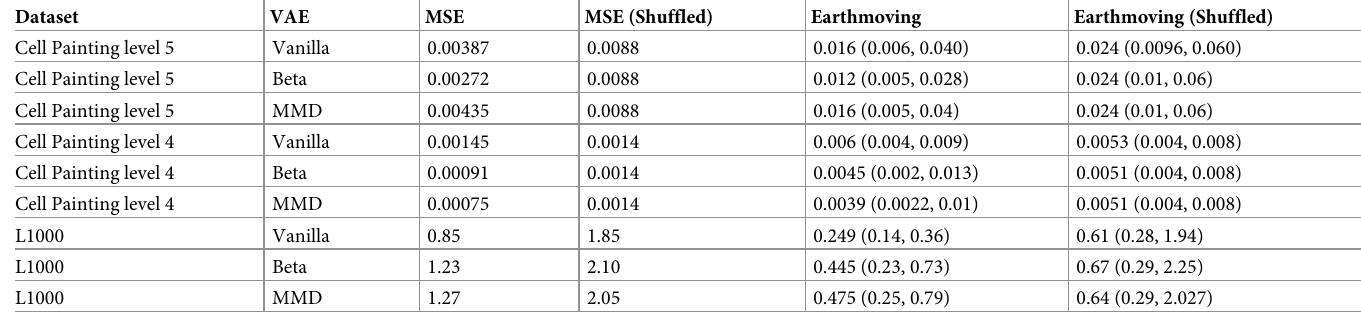
Table 1. Mean squared error (MSE) and earthmoving distance for VAE’s ability to reconstruct Cell Painting and L1000 profiles. We compare these values with results derived from shuffled models. Earthmoving distance is calculated by taking the mean of the earthmoving distance of each sample. We add the 95% percentile range of earthmoving distance in parenthesis (0.05 lowest, 0.95 highest). Note that since our models required that we normalize Cell Painting and L1000 input data differently (see Methods), the metrics cannot be compared across data